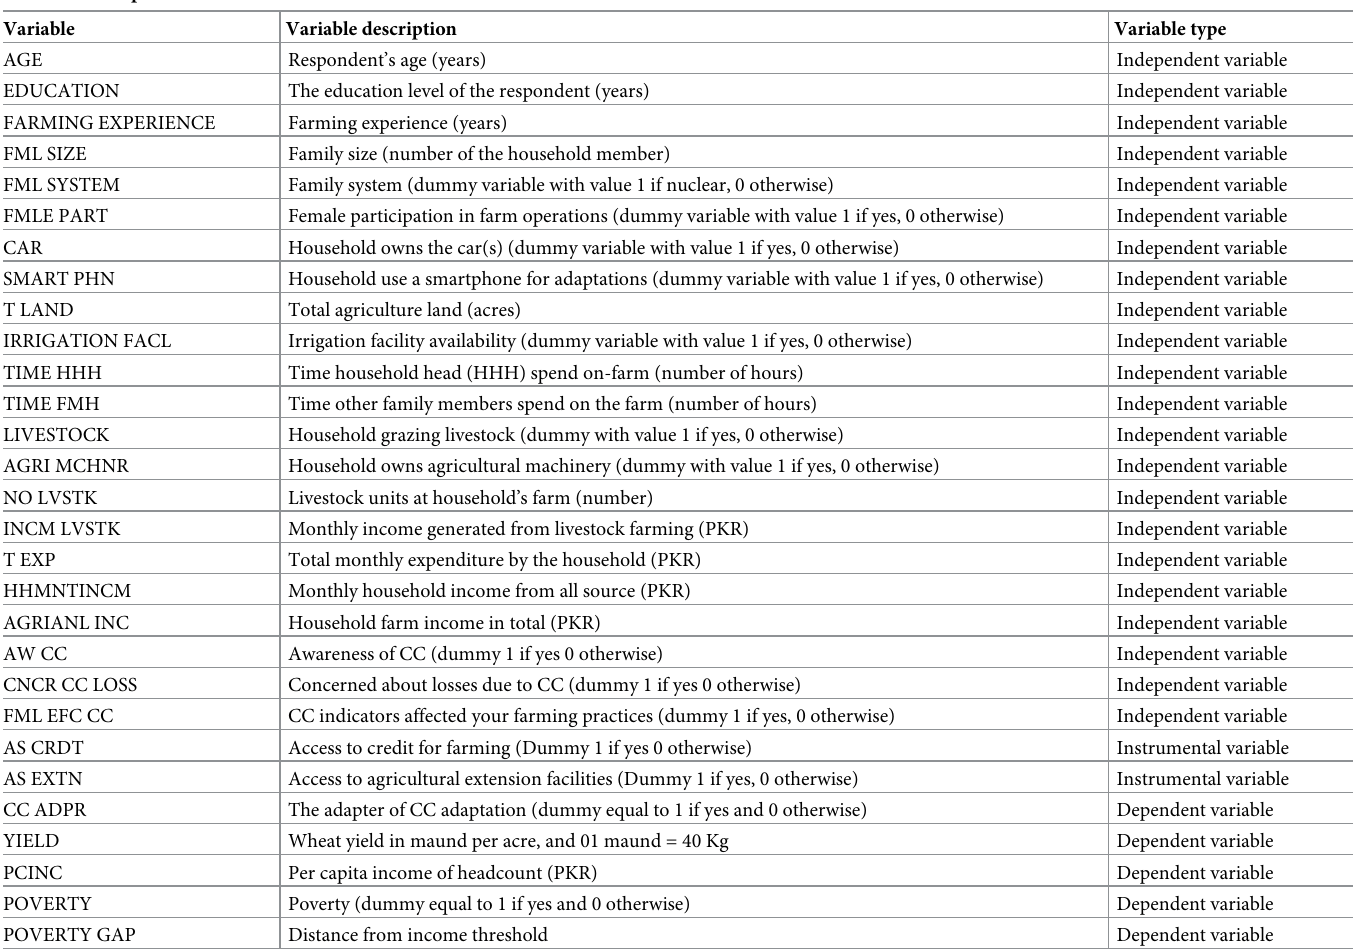
Table 2. Description of selected